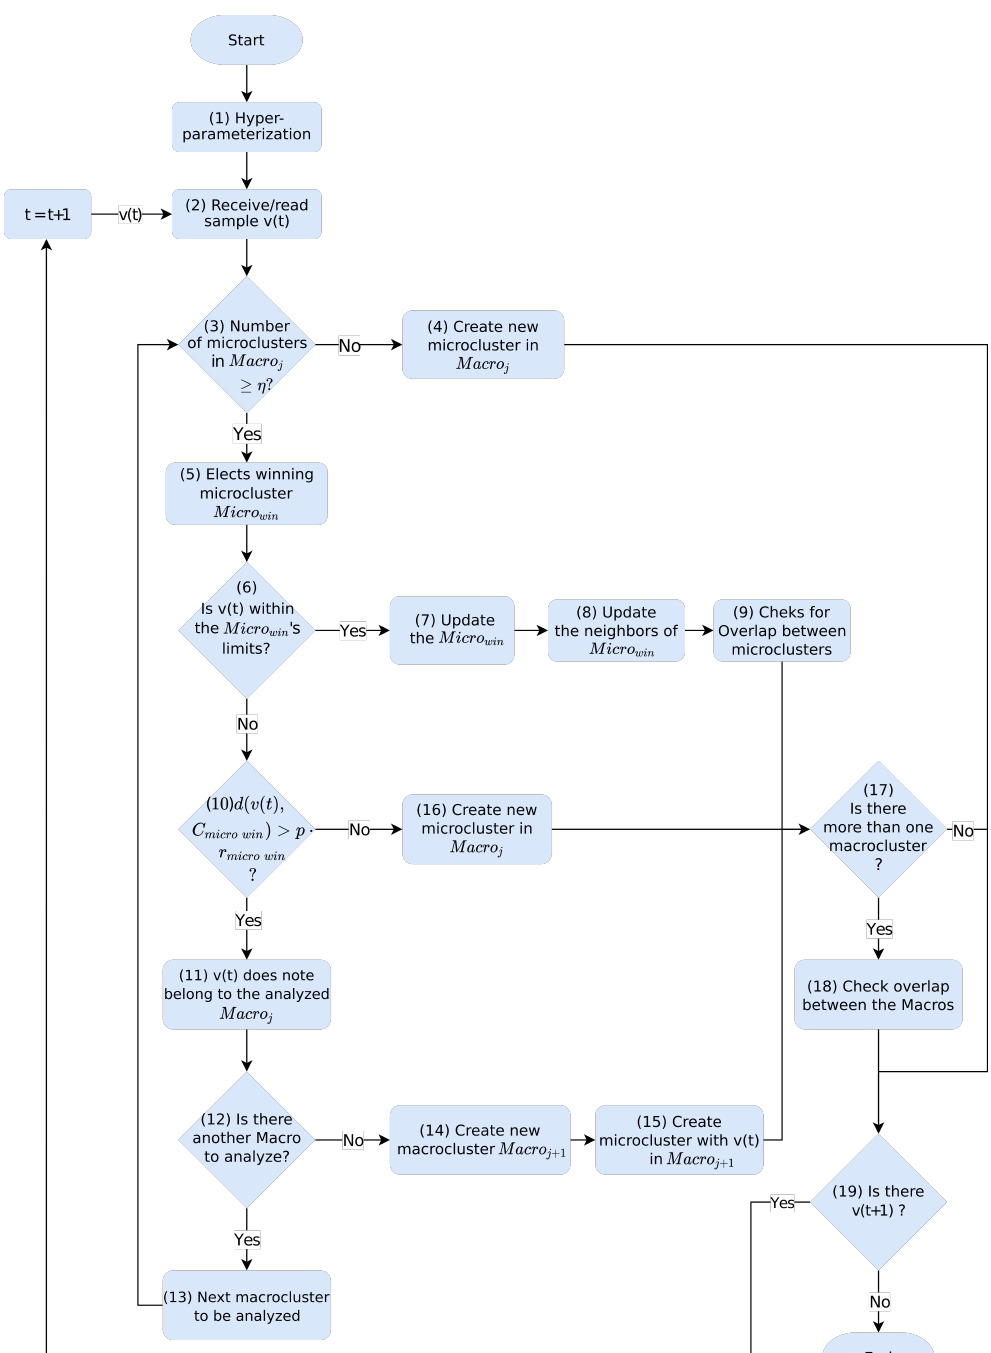
Figure 2. Diagram of the Macro SOStream algorithm, where the representation (XX) indicates the steps cited from the